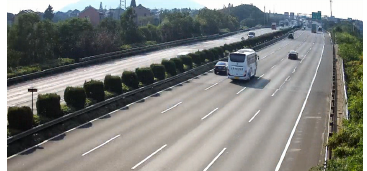
Figure 10. The real situation of Scene 2.